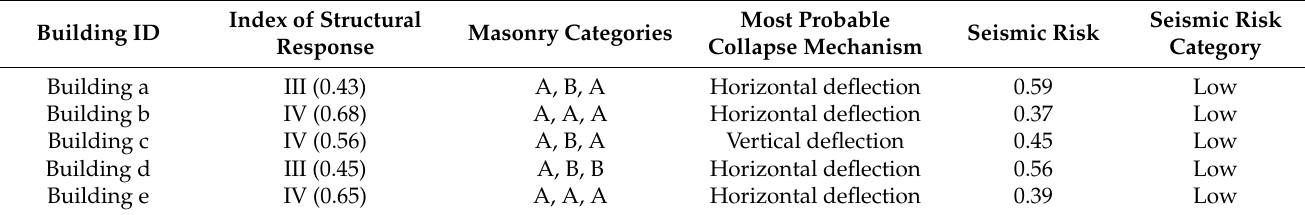
Table 9. Results of evaluation of building around the Podvorje square.